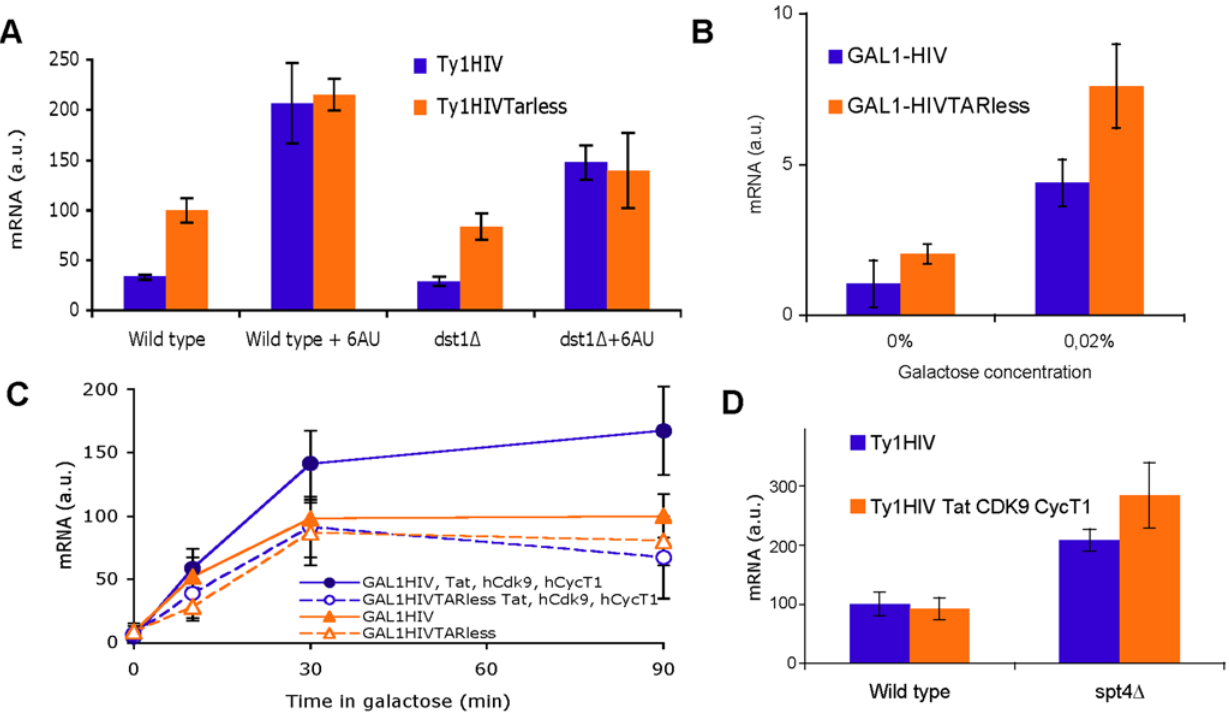
Figure 2. No effect of the 5 9 HIV-TR on mRNA levels upon promoter activation. (A) Activation of the Ty1 promoter by the NTP-depleting agent 6-azauracil eliminates the inhibitory effect of the 5 9 HIV-TR, both in a wild type and in a strain lacking TFIIS ( dst1 D ) . Experiment details as for Figure 1A. (B) The 5 9 HIV-TR inhibits GAL1 -driven transcription when the promoter is weakly active. Cells transformed with plasmids pGAL1-HIV or pGAL1-HIVTARless were grown to mid-log phase in minimal medium with raffinose (0%) or with raffinose plus 0.02% galactose (0.02%) as carbon sources. (C) No effect of the 5 9 HIV-TR on mRNA levels is detected when an activated GAL1 promoter drives transcription, unless Tat and P-TEFb are present in the yeast cell. Cells transformed with plasmids pGAL1-HIV or pGAL1-HIVTARless, alone or together with p415GPD-CycT1, p414GPD-Cdk9 and p413GPD-Tat, were grown to mid-log phase as in B and incubated for 90 min in the presence of 2% galactose. (D) Tat and P-TEFb enhance Ty1- HIV expression in spt4 D but they do not alter basal transcription in the wild type. Cells transformed with plasmids pTy1-HIV or pTy1-HIVTARless, alone or together with p415GPD-CycT1, p414GPD-Cdk9 and p413GPD-Tat, were grown to mid-log phase. In all cases, mRNA samples were taken and analyzed by Northern blot as in Figure 1A and the averages of three independent experiments are